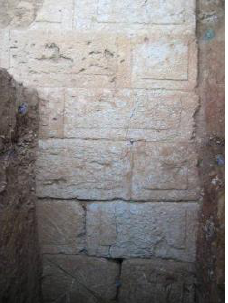
Figure 2. Part of Pre-Roman rampart© F. Allegrini-Simonetti - CTC